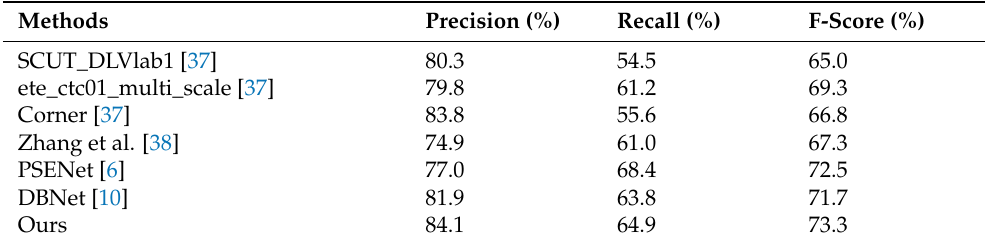
Table 6. Performance comparison of the model proposed in this paper with other models on the ICDAR2017-MLT